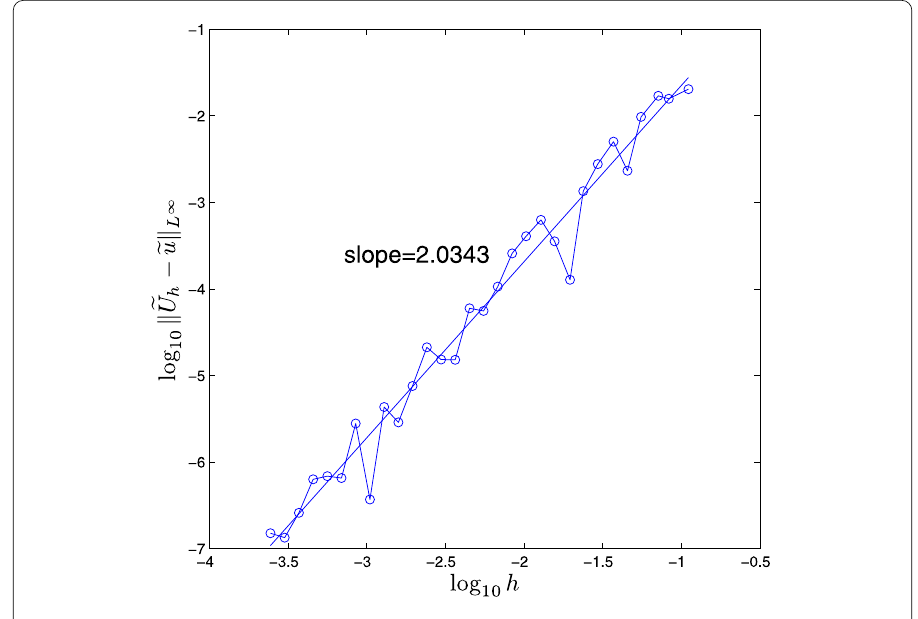
Figure 4 Numerical results obtained by the augmented method for Example 2 with β 1 = 1 and β 2 = 20